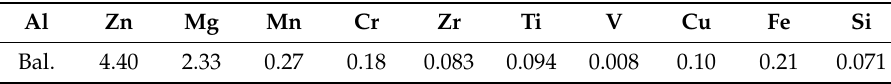
Table 1. Chemical composition of 7A52 aluminum